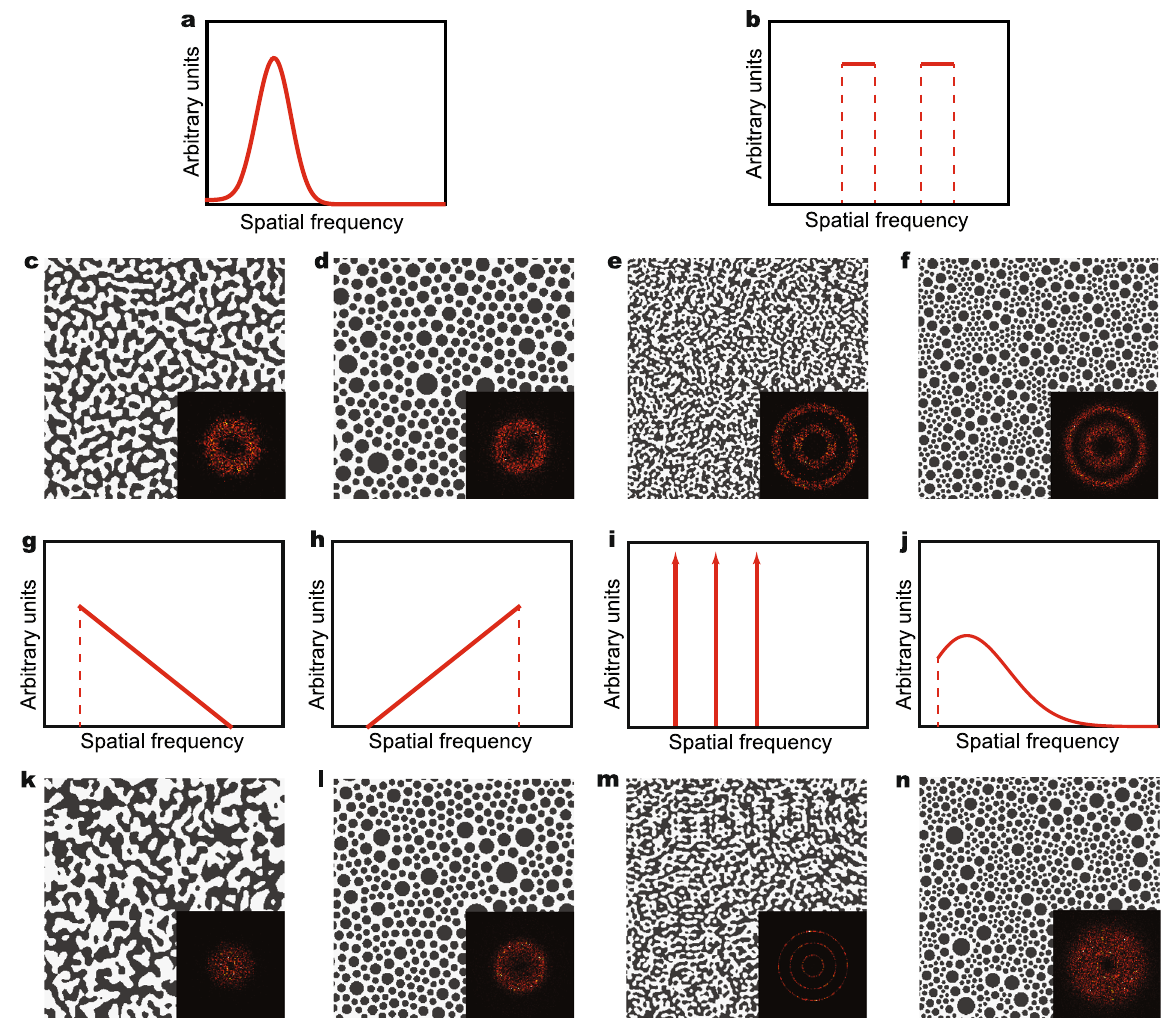
Figure 2. Real-space quasi-random structure reconstruction from SDF. ( a ) An SDF following the Gaussian distribution function. ( b ) An SDF following two-step function. ( c ) A channel-type quasi-random structure reconstructed from ( a ) using Gaussian random field modeling. ( d ) A disk-type quasi-random structure reconstructed from ( a ) using random packing algorithm. ( e ) A channel-type quasi-random structure reconstructed from ( b ) using Gaussian random field modeling. ( f ) A disk-type quasi-random structure reconstructed from ( b ) using random packing algorithm. ( g ) An SDF following a decreasing-linear function. ( h ) An SDF following an increasing linear function. ( i ) An SDF following a triple-delta function. ( j ) An SDF following a truncated Gaussian distribution function. ( k ) A channel-type quasi-random structure reconstructed from ( g ) using the Gaussian random field modeling. ( l ) A disk-type quasi-random structure reconstructed from ( h ) using the random packing algorithm. ( m ) A channel-type quasi-random structure reconstructed from ( i ) using the Gaussian random field modeling. ( n ) A disk-type quasi-random structure reconstructed from ( j ) using the random packing